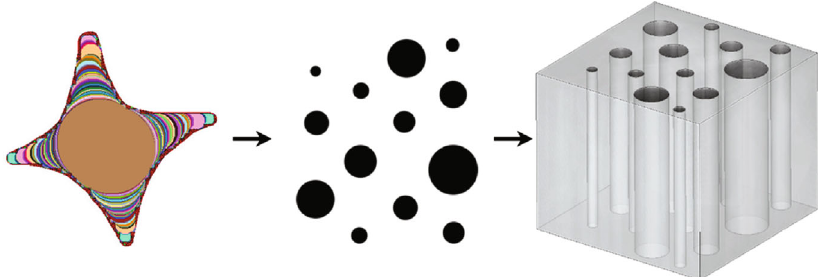
Figure 3: Capillary bundle model of porous media.